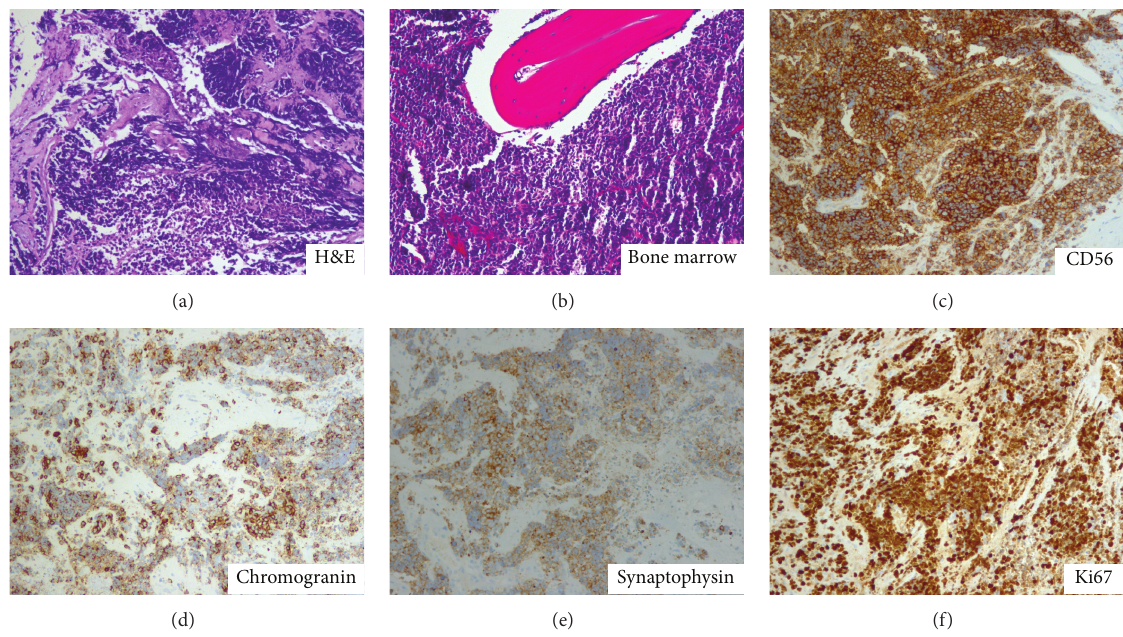
Figure 4: Pathology of the left nasal mass and bone marrow shows small cell undifferentiated (neuroendocrine) carcinoma. Light microscopy showed small round cells with scanty cytoplasm and hyperchromatic nuclei ((a) and (b)). Immunohistochemical staining showing tumor positivity for CD56 (c), chromogranin (d), and synaptophysin (e) (IHC × 100) and nuclear positivity to Ki-67 (f) (IHC ×